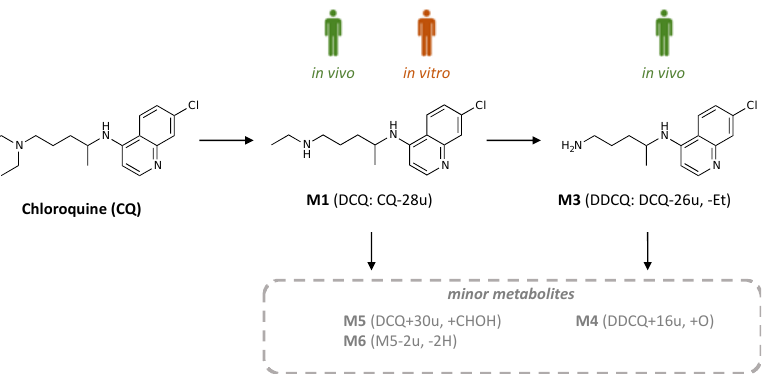
Figure 4. Metabolites formation pathway of chloroquine (CQ) based on FeTPPS metalloporphyrin catalyzed biomimetic oxidation. M1 : N-desethyl-chloroquine (DCQ), M3 : N-didesethyl-chloroquine (DDCQ), and minor metabolites M4 , M5 : hydroxymethylated N-desethyl-chloroquine and M6 : N-formamide analogue of M5 .